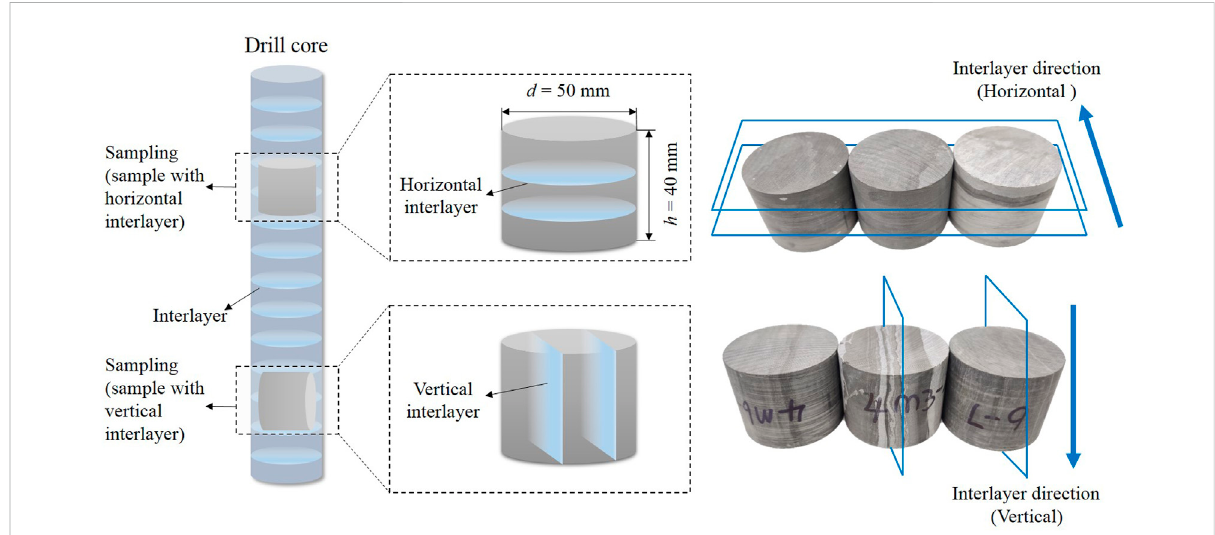
FIGURE 3 Sampling diagram and dolomite sample with interlayer in different directions.